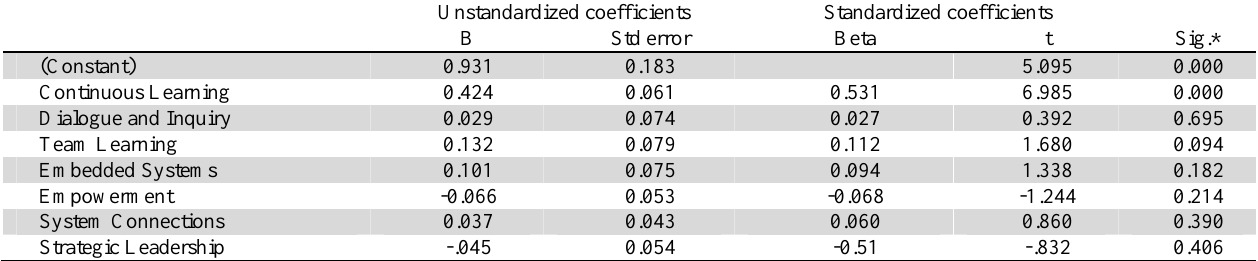
Regression equation- knowledge acquisition and learning organization dimensions Unstandardized coefficients